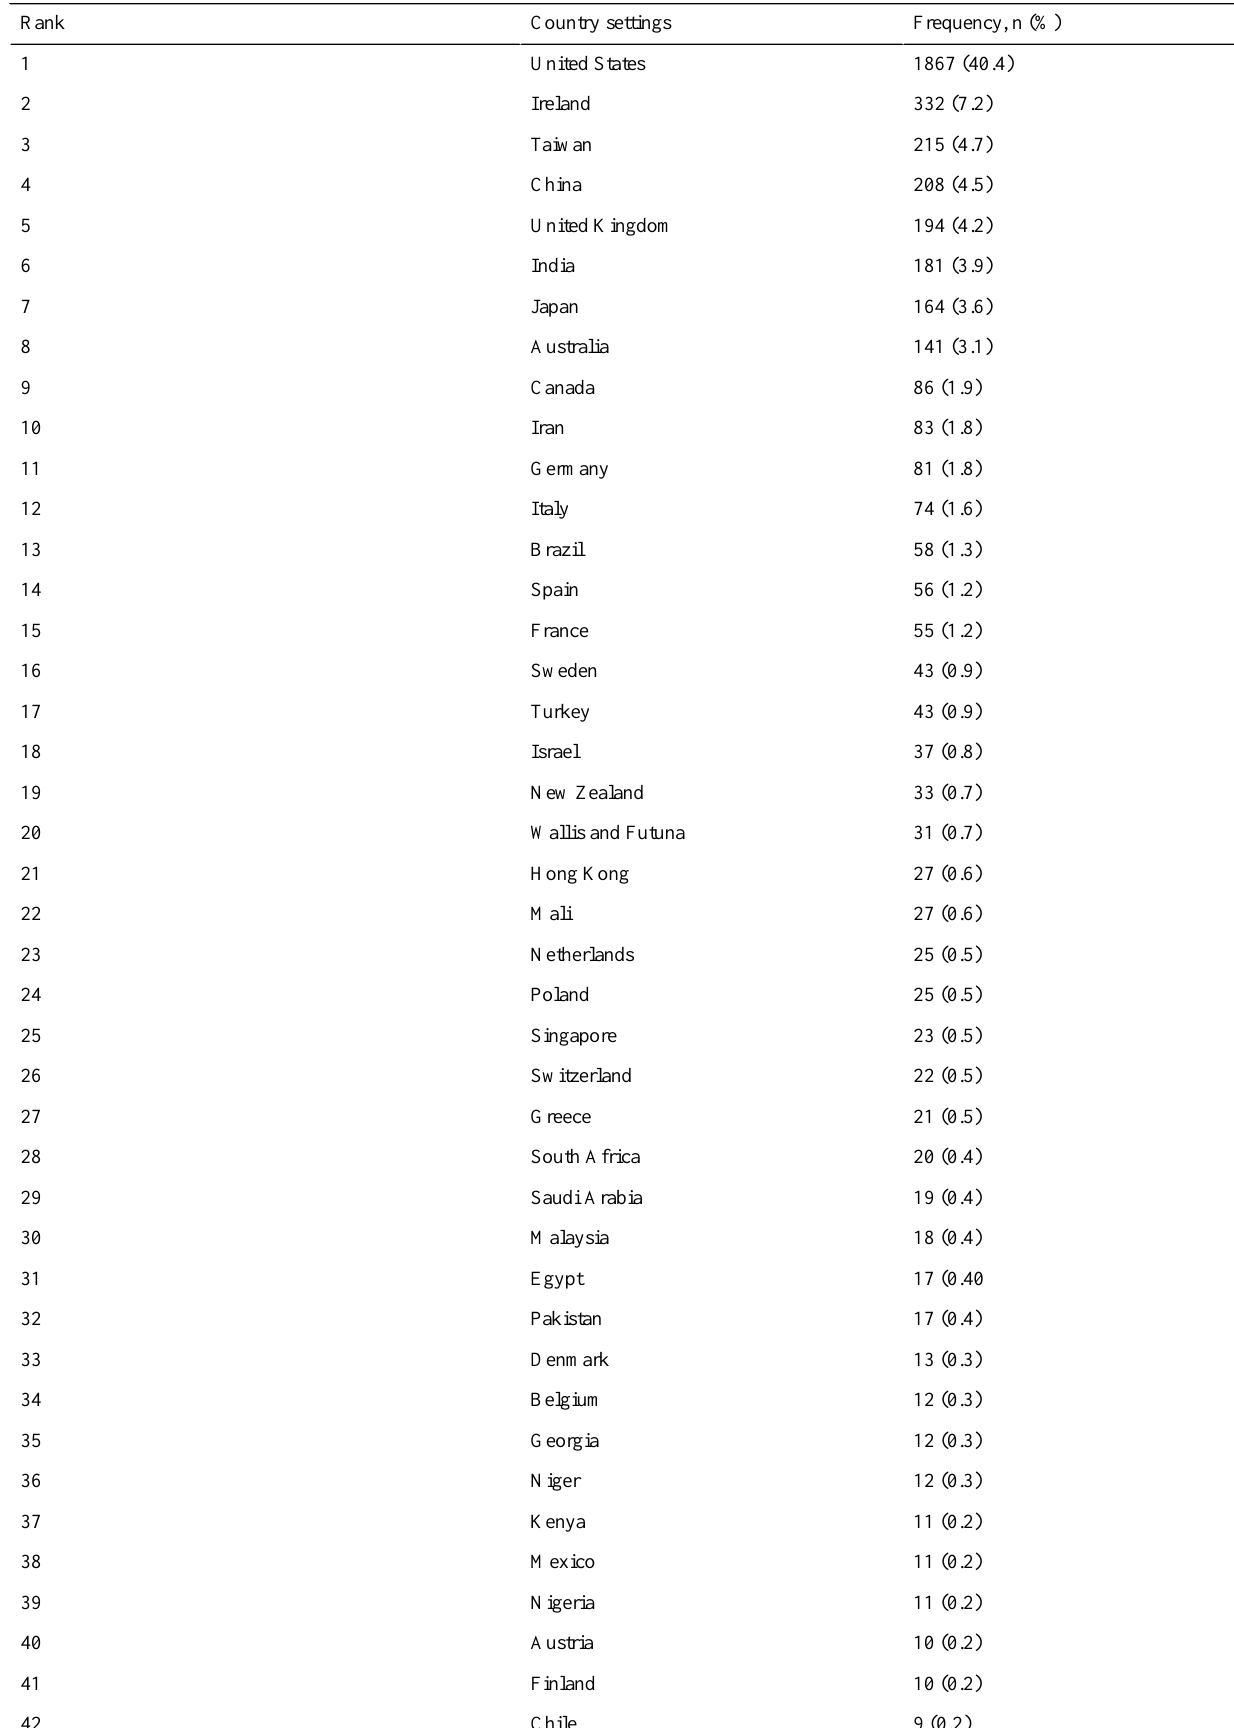
Table 3. Number of papers by countries as study